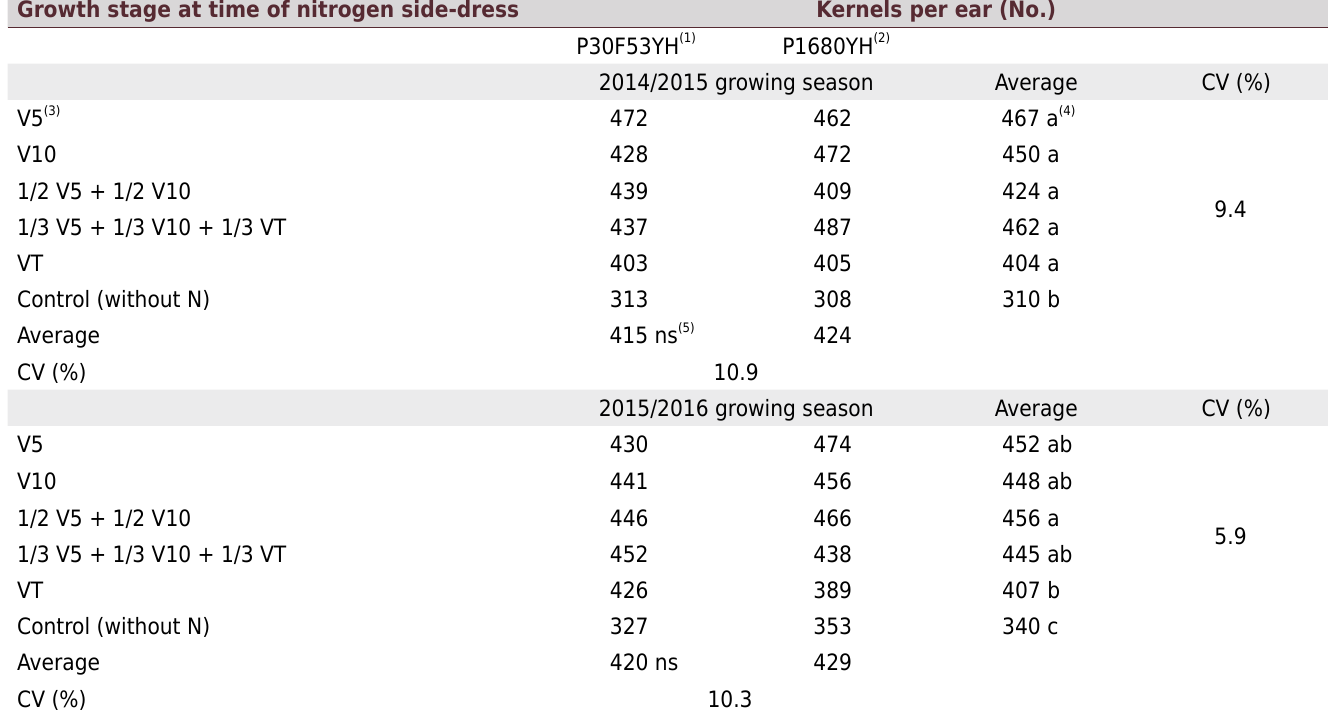
Table 4. Number of kernels per ear of two corn hybrids as affected by the growth stage of plants at time of nitrogen side-dress fertilization in Lages, Santa Catarina, Brazil Growth stage at time of nitrogen side-dress Kernels per ear